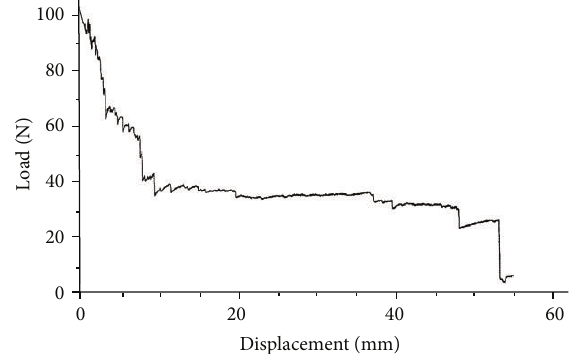
Figure 7: Typical force-displacement curve for a T-peel test for adhesive